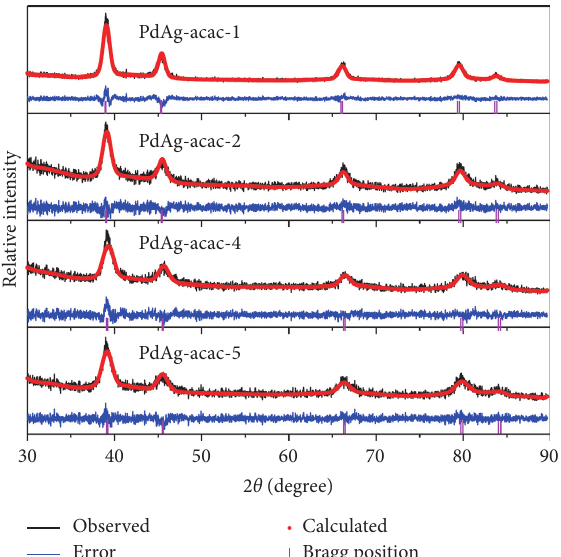
Figure 1: XRD patterns and Rietveld refinement results of PdAg-acac-1, PdAg-acac-2, PdAg-acac-4, and PdAg-acac-5.